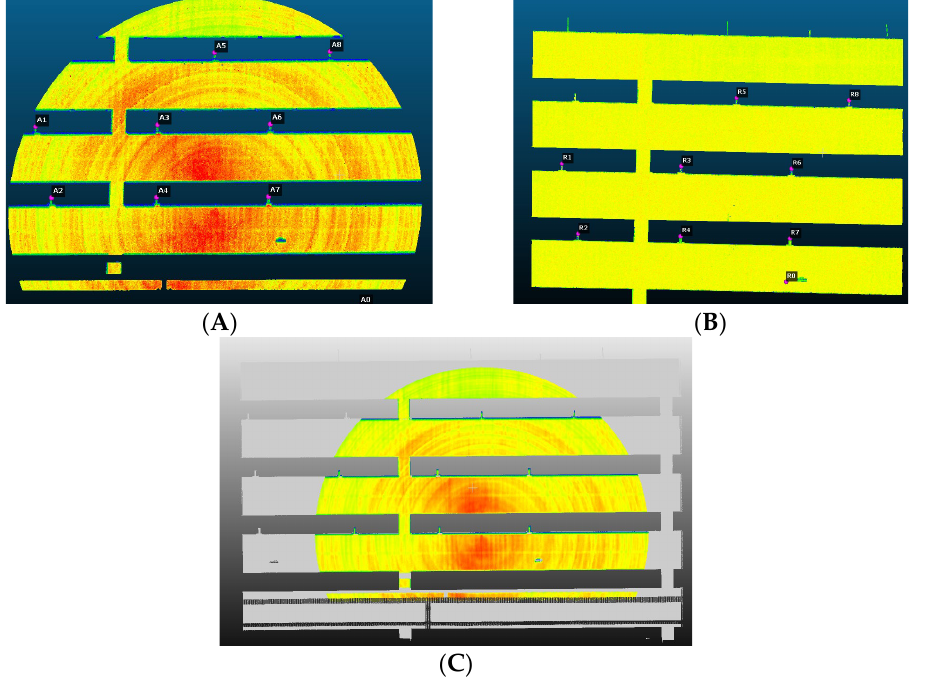
Figure 13. Alignment of ( A ) the Livox ® Mid–40-point cloud with ( B ) the Riegl ® VZ-400 point cloud using alignment targets placed on the target surface and ( C ) subsequent interpolation of scalar fields.